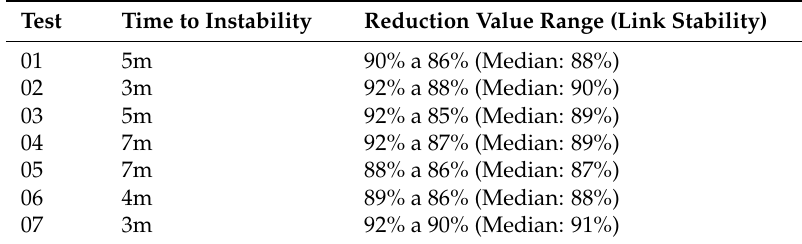
Table 6. Preliminary test